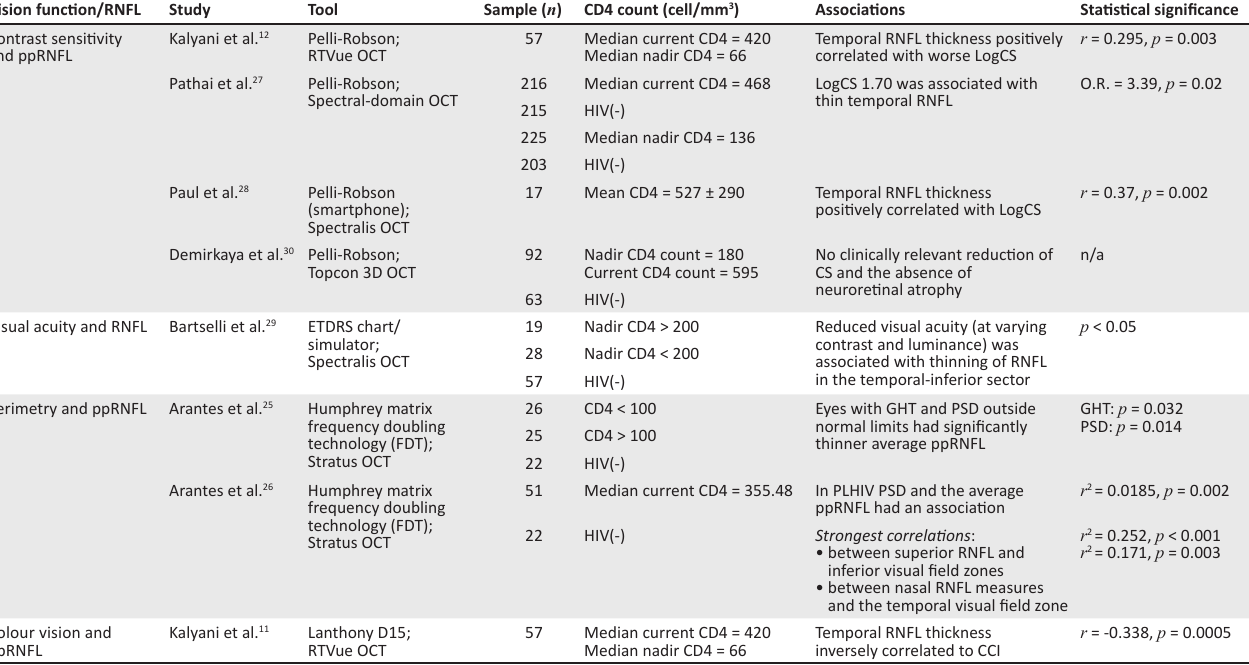
TABLE 3: Studies investigating the relationship between the retinal nerve fibre layer and visual function in people living with HIV on antiretroviral therapy with no retinitis. Vision